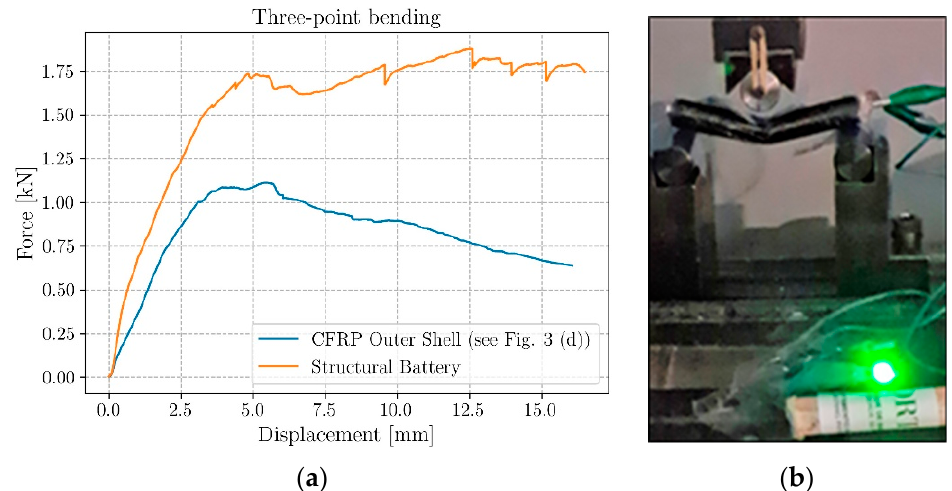
Figure 8. Three-point bending test; ( a ) Force vs. displacement curves for a structural battery and the CFRP outer shell only, ( b ) structural battery lighting an LED while the mechanical test is per- formed.